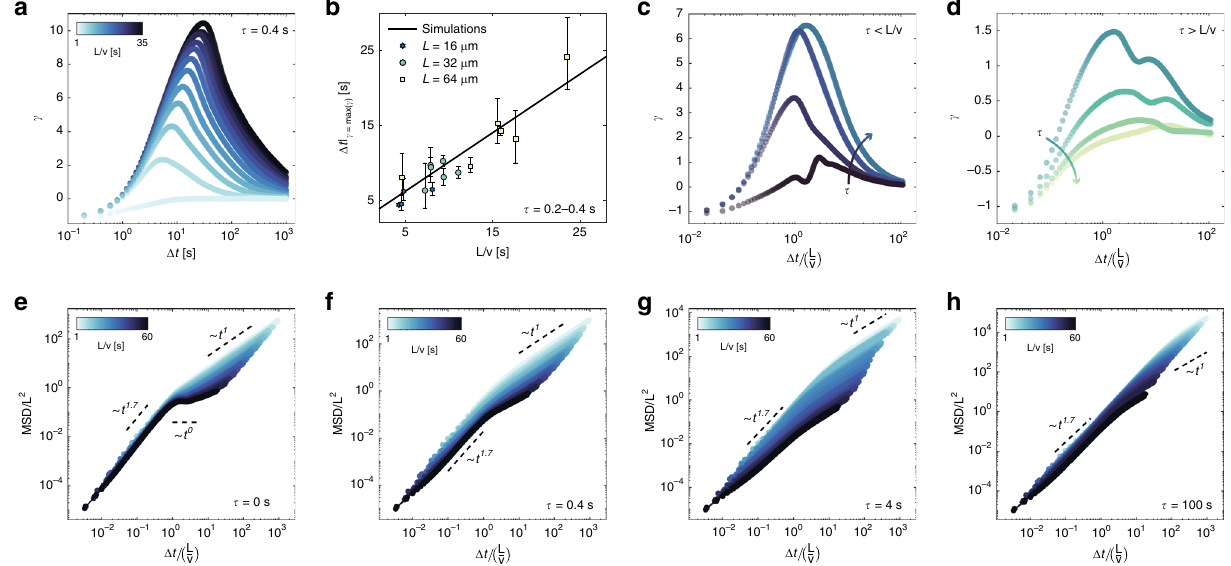
Fig. 4 Role of the timescale L / v and sampling period τ on the statistics of particle motion. a Simulated evolution of the excess kurtosis γ of the distribution of one-dimensional displacements G ( x / L , Δ t ) with Δ t for different values of L / v at a constant τ = 0.4 s. b Experimental and simulated Δ t at which γ attains its maximum as a function of L / v ( τ = 0.2 – 0.4 s). Error bars denote 95% con fi dence intervals. c – d Simulated evolution of γ with Δ t ( L / v ) − 1 for τ < L / v ( c ) and τ > L / v ( d ), with L = 32 μ m and v = 3.5 μ m s − 1 . The black circles corresponds to τ = 0. e – h Simulated evolution of the rescaled